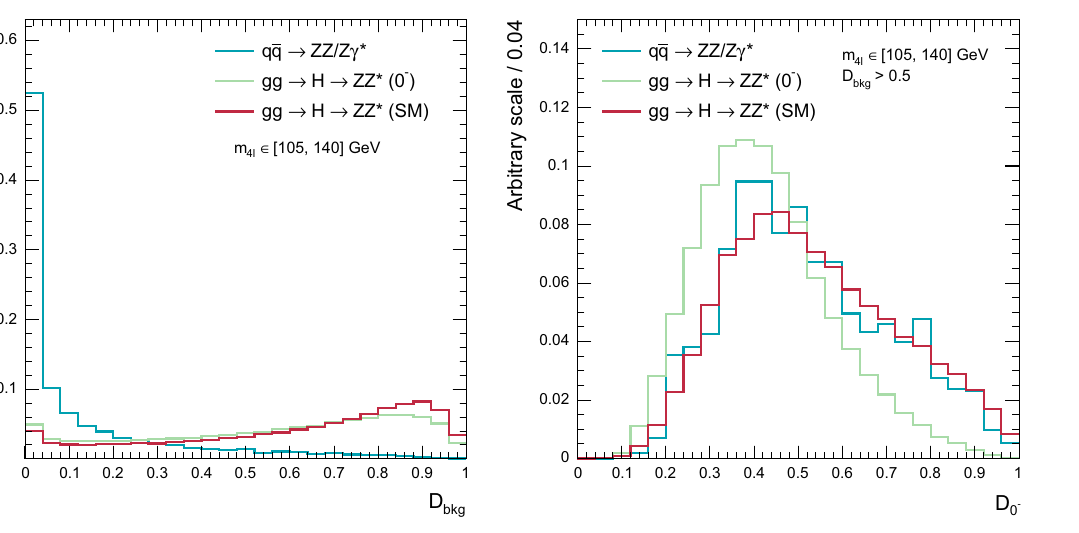
that both the background and the SM Higgs processes have similar dis- tributions of the D 0 − discriminant. All distributions are normalised to unit